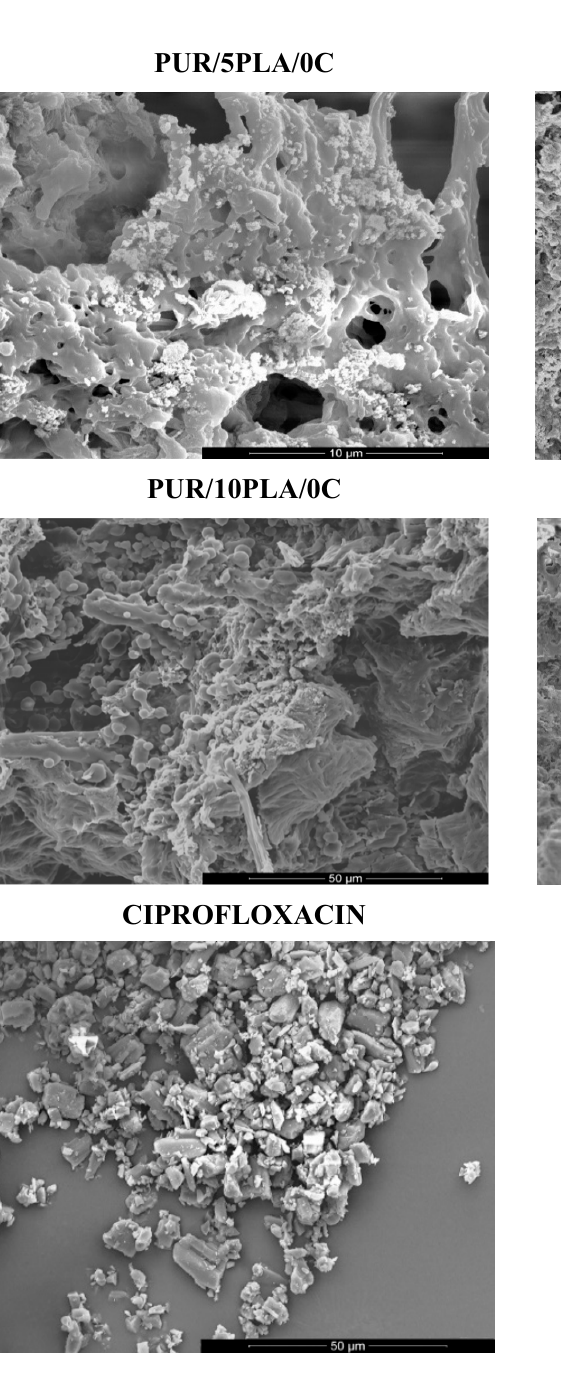
Figure 3. SEM images of unmodified and Cipro-modified (2 or 5 wt %) HPPS, obtained by using 5 or 10 wt % of PLA and a SEM image of ciprofloxacin used for HPPS modification.